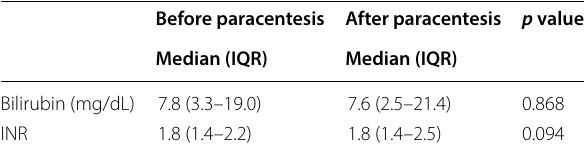
Table 2 Main conventional laboratory parameters of liver function before and after paracentesis (overall time interval of 24